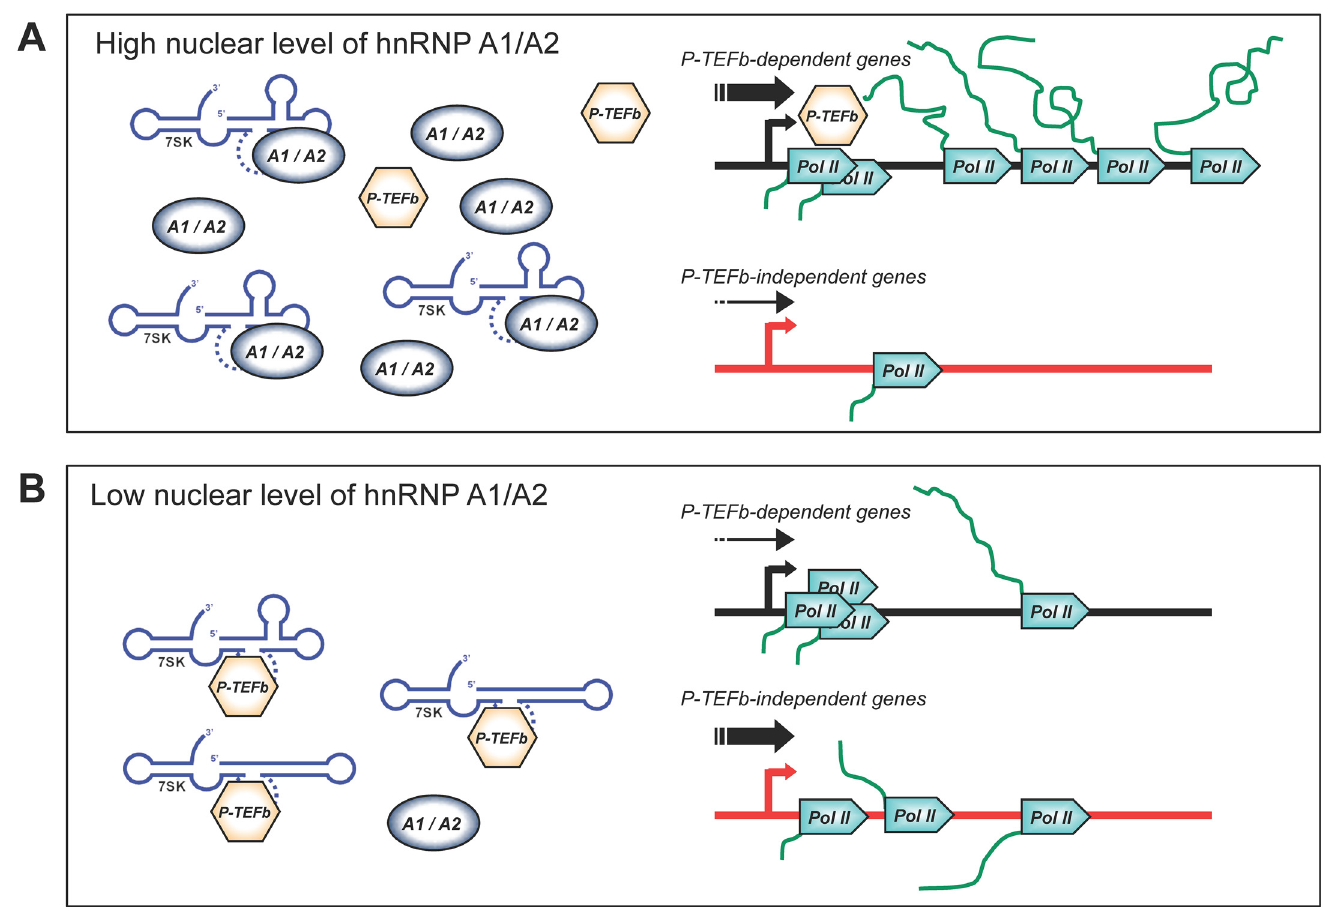
Fig 9. Model to explain how a decrease in hnRNP A1/A2 proteins reduces transcription elongation of P-TEFb-dependent genes but stimulates expression of P-TEFb-independent genes. In panel A, normally high levels of nuclear hnRNP A1/A2 proteins ensure the release of P-TEFb from the repressor 7SK RNP which is used for the efficient transcription of P-TEFb-dependent genes, such as Kitlg and many genes encoding ribosomal proteins. A reduction in the levels of nuclear hnRNP A1/A2 proteins (panel B) would prevent the efficient release of P-TEFb from 7SK, eliciting promoter-proximal pausing of RNA polymerase II on P-TEFb-dependent genes, and a decrease in their expression. The stalling of polymerases at promoter-proximal locations would reduce the average number of polymerases associating with P-TEFb-dependent genes, thereby increasing the level of free polymerases which would then associate preferentially with, and stimulate the expression of, P-TEFb-independent genes, such as the mycUP1 reporter gene and Egr1